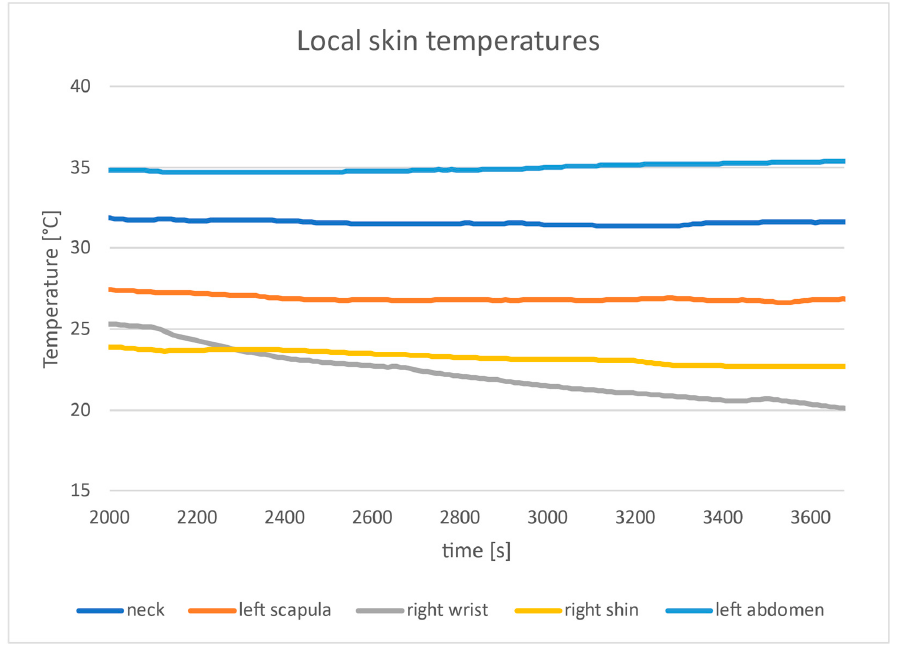
Figure 9. Local skin temperatures for participant A when adjusting to reach subjective thermal comfort.